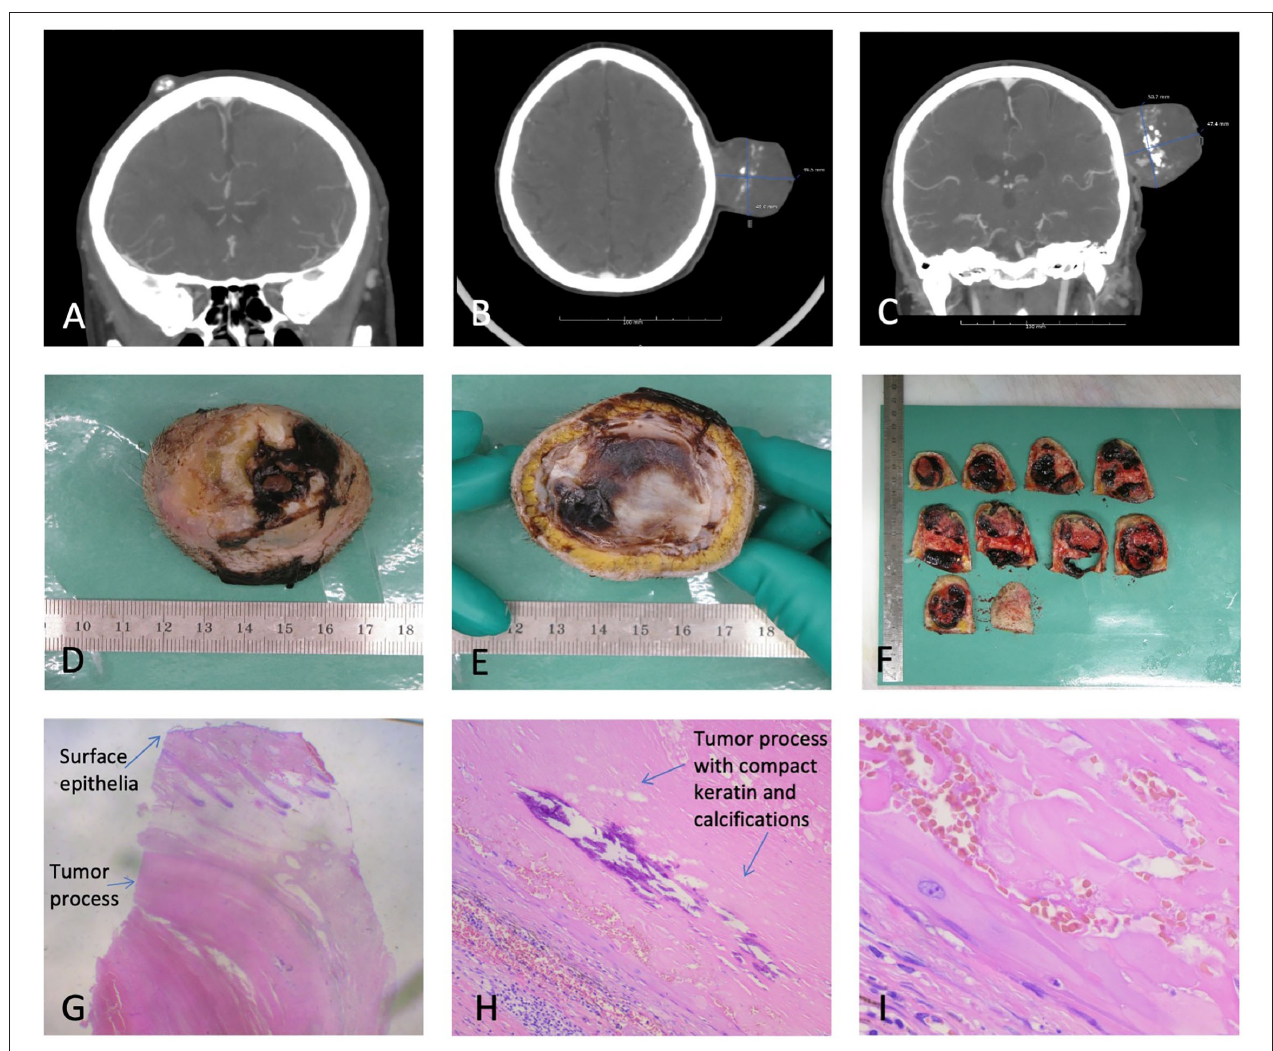
FIGURE 3 | (A) One of the two smaller TCs. (B) PTC axial view. (C) PTC coronal view. (D,E) Macroscopy of the PTC. (F) Macroscopic view of sliced PTC. (G) Microscopy of PTC, depicting surface epithelia and a tumor process. (H) Microscopy depicting the compact keratin and calcifications. (I) Microscopy with squamous epithelial cells without a granular cell